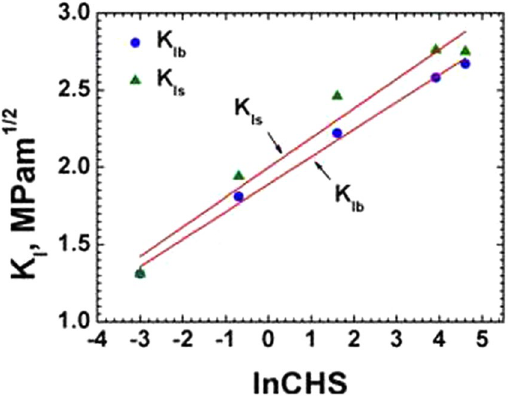
Figure 4. Plot of anticipated KIb and KIs as a function of ln CHS at 25 °C.